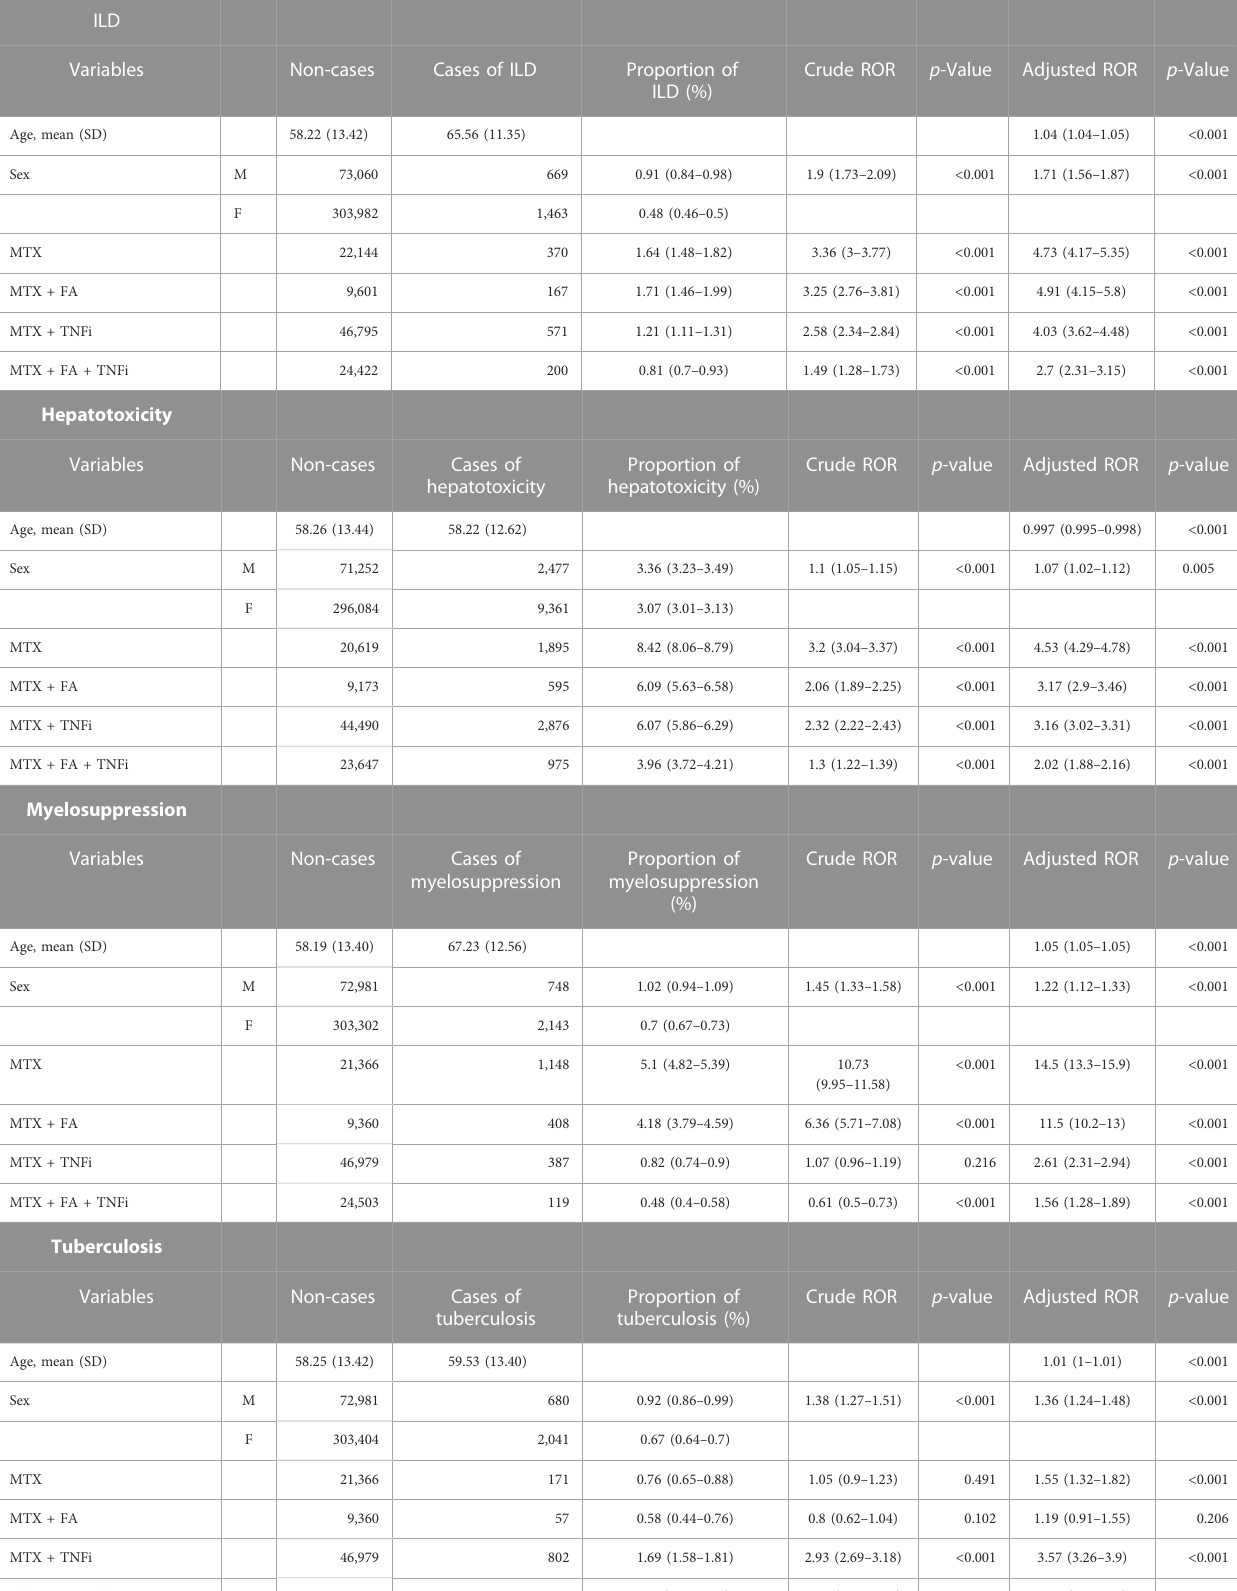
TABLE 3Crudeand adjusted RORs (95% CI)for MTX-related adverse events calculated using the logistic regression analysis for eachtreatment patterncontaining MTX in RA cases.